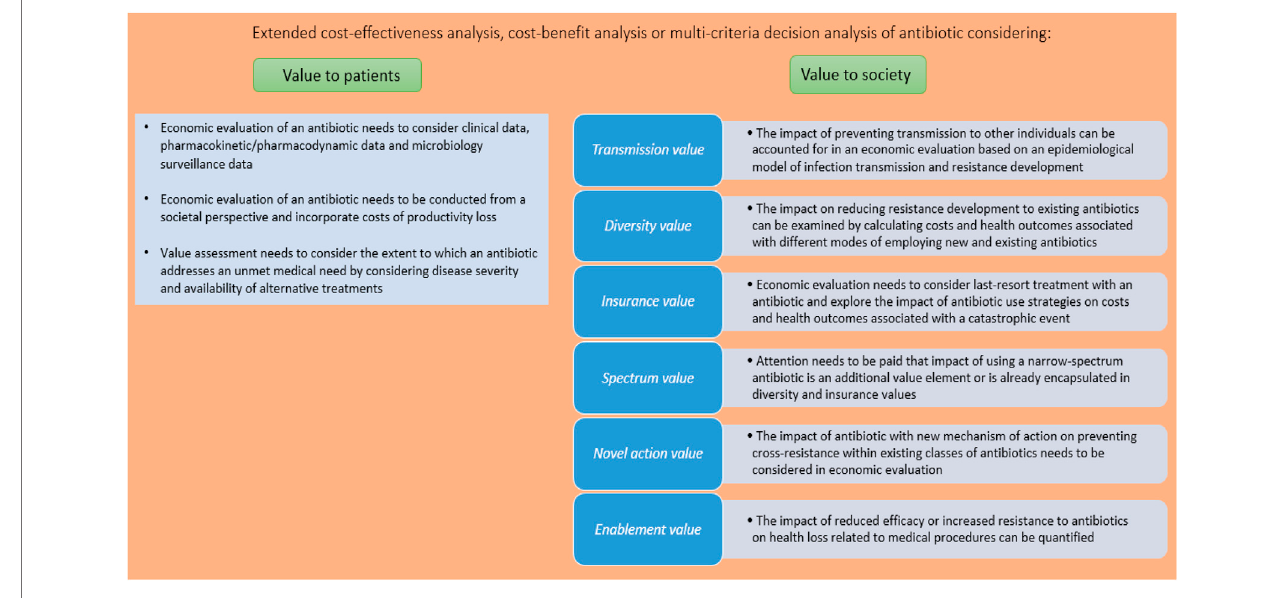
FIGURE 1 | Assessing the value of